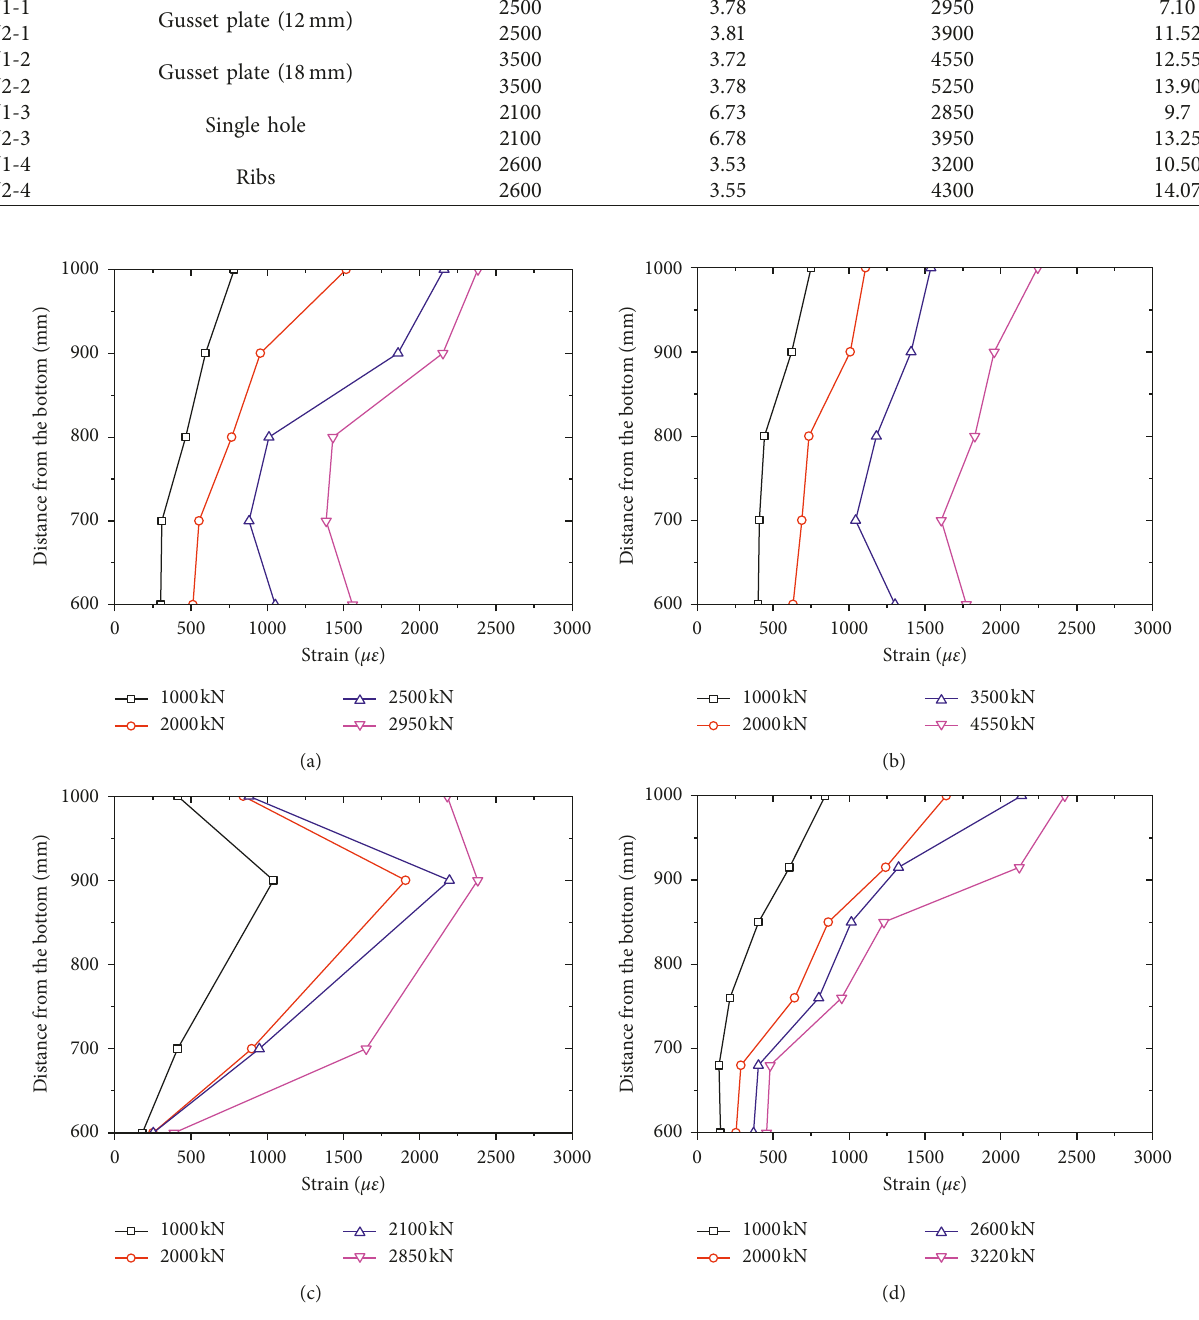
Figure 8: Strain distribution along the gusset plate: (a) SJ1-1; (b) SJ1-2; (c) SJ1-3; (d)